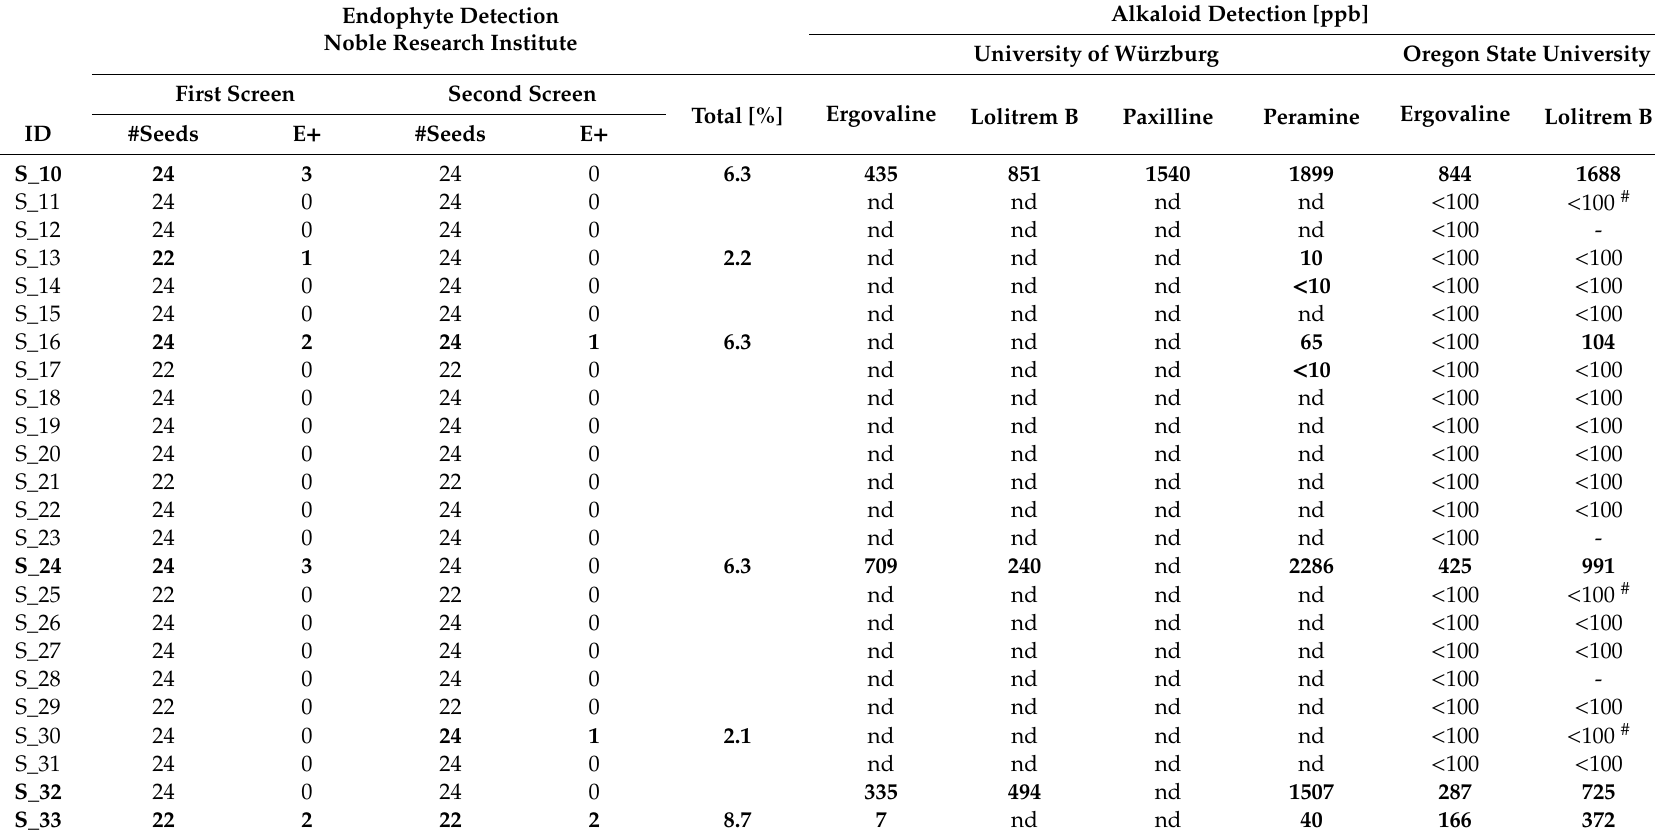
Table 2. Endophyte detection in the Noble Research Institute and quantification of alkaloids at the University of Würzburg and the Oregon State University. Bold numbers / letters indicate that sample was infected / alkaloids were detected. University of Würzburg: one replicate (around 50 mg) of each ground seed mixture was analyzed. Oregon State University: two replicates were analyzed with the exception of samples indicated with # with only one replicate. nd = not detected; - not